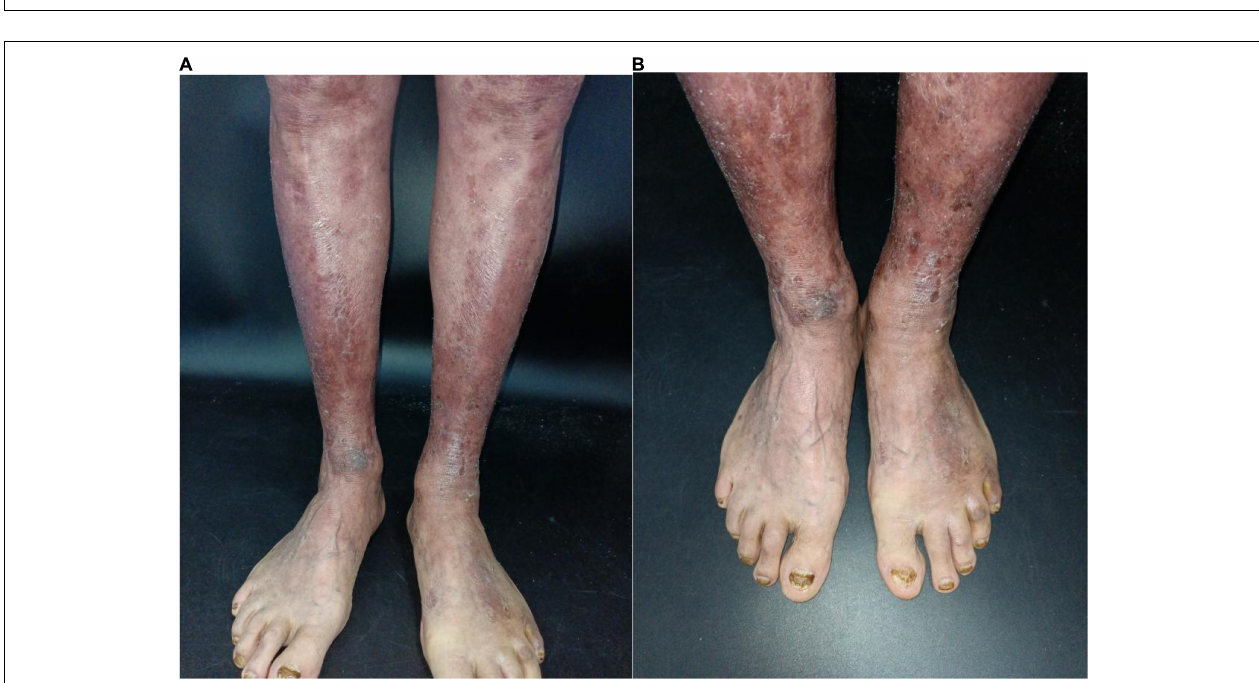
FIGURE 2 | Skin histopathology of the patient. (A) A biopsy specimen of the right limb showed spindle cell proliferation, with intermingled erythrocytes seen in the dermis (Hematoxylin and eosin, × 25). (B) Significant atypia of endothelial cells. (Hematoxylin and eosin, × 100).